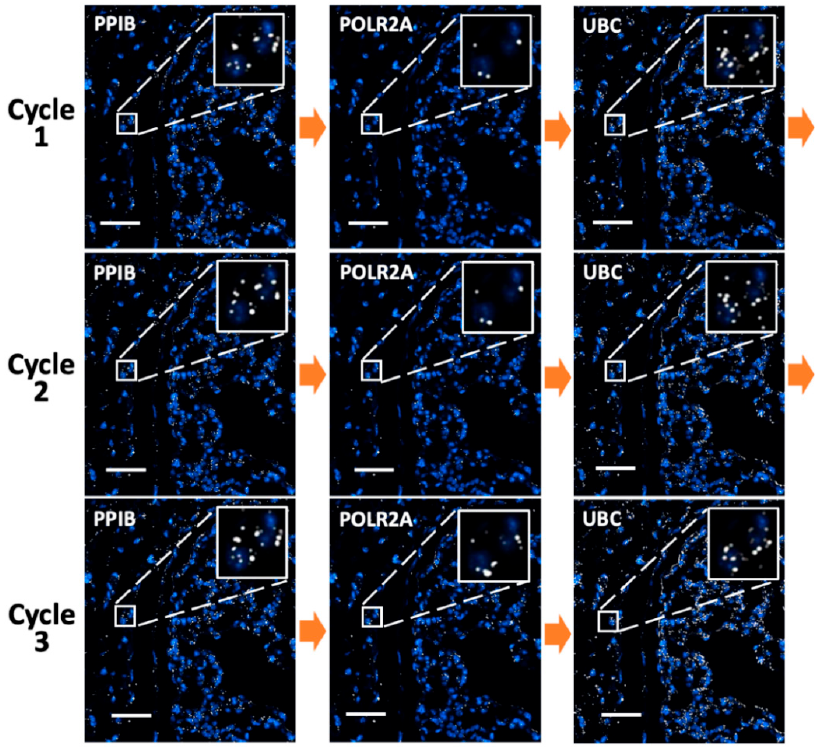
Figure 3. mRNA PPIB, POLR2A, and UBC in an FFPE mouse lung tissue are sequentially stained with tyramide-N 3 -Cy5 in three reiterative cycles. Scale bar, 50 µ